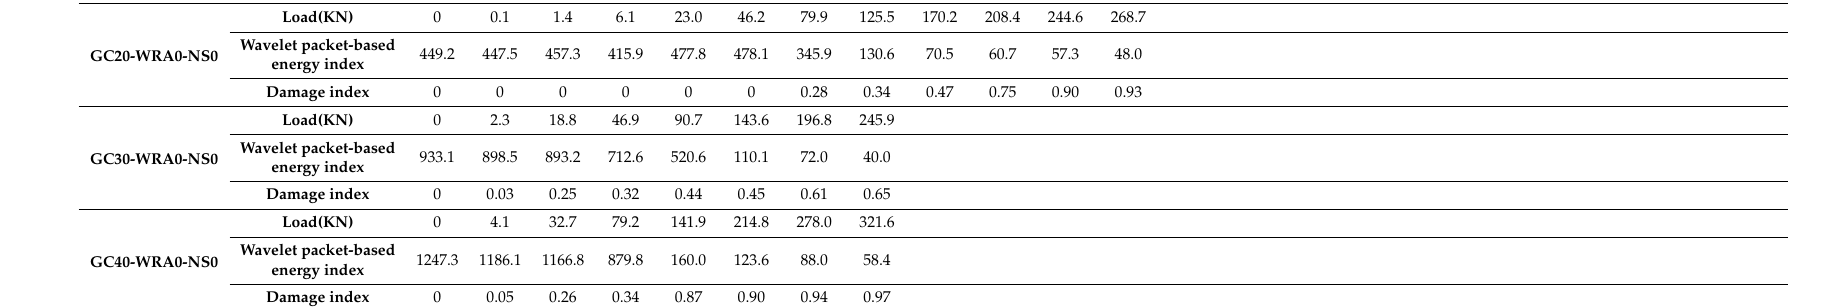
Table 3. Specimen loading and data